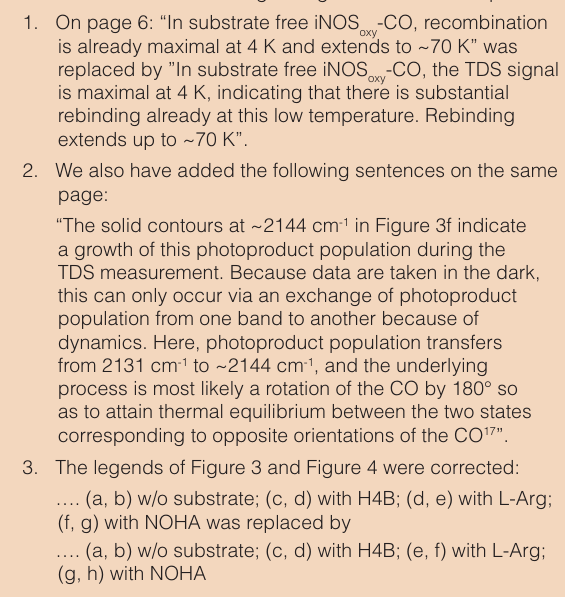
Figure 1. Schematic depiction of the iNOS 1NOD and 1DWV). The CO ligand was added for